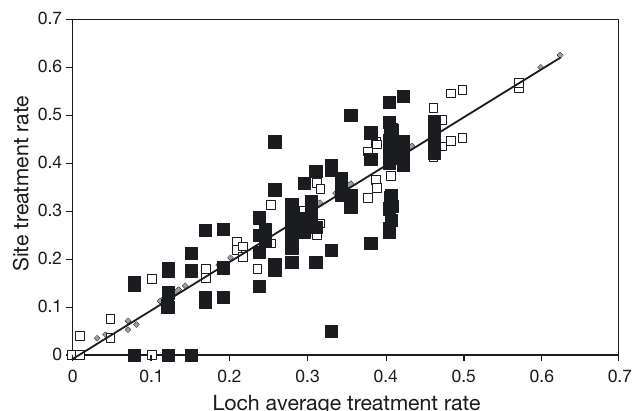
Fig. 2. Treatment rate of sites versus loch treatment rate averaged over all sites in Scottish sea lochs (Fig. 1). Small diamonds: lochs containing only one site; white squares: lochs containing only 2 sites; black squares: lochs